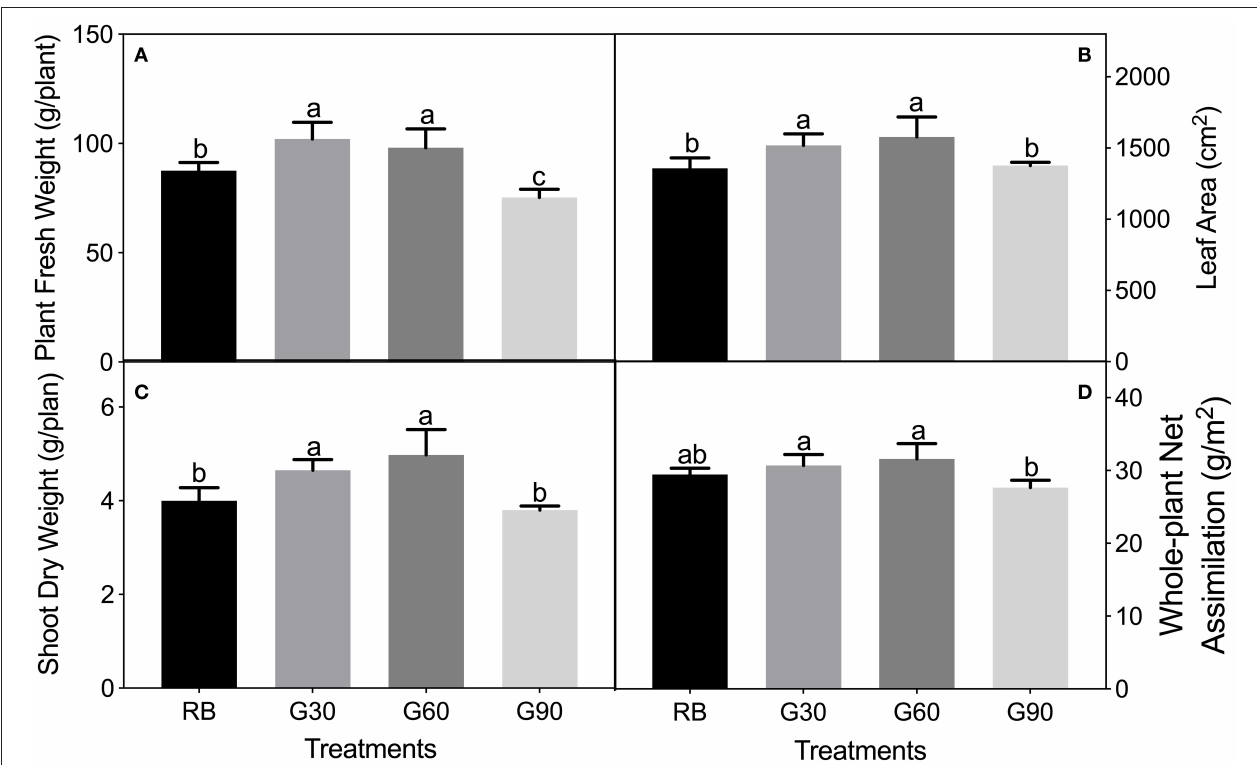
FIGURE 2 | Plant fresh weight (A) , leaf area (B) , shoot dry weight (C) , and whole-plant net assimilation (D) of lettuce plants as affected by the different proportions of green light. Different letters in each column indicate significant differences at p < 0.05, according to the least significant difference (LSD) test.